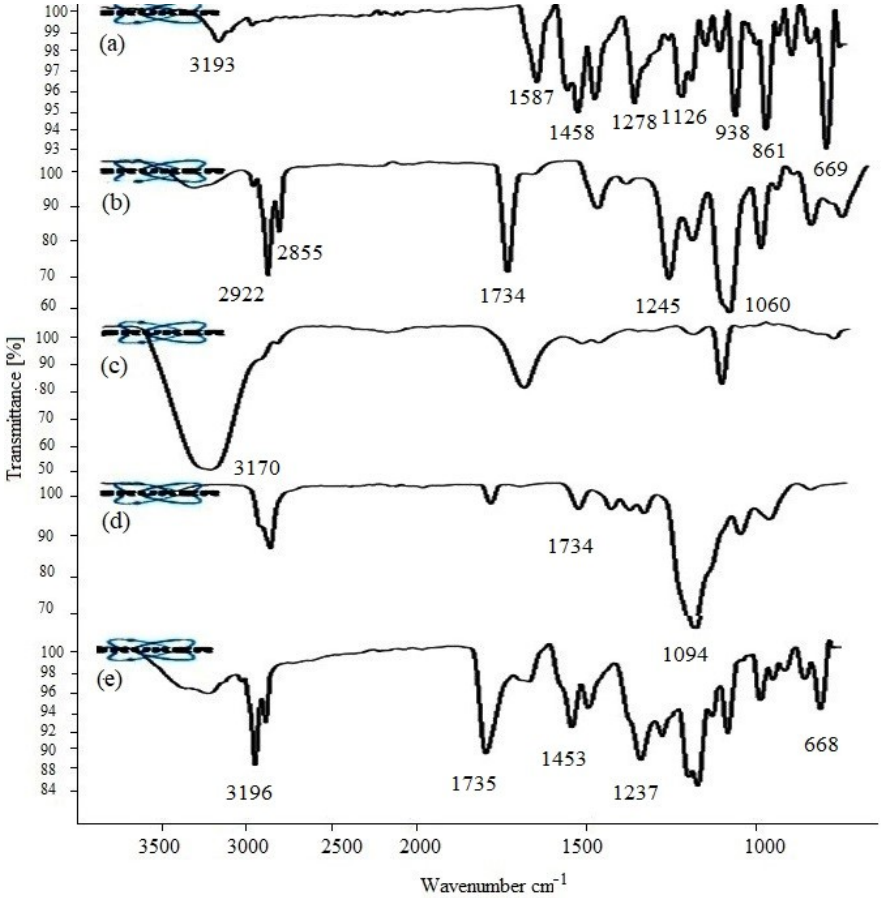
Figure 1. FTIR spectra of pure voriconazole ( a ), lipoid S100 ( b ), carbopol ( c ), Tween 80 ( d ), and voriconazole, carbopol, and lipoid S100 mixture ( e ).